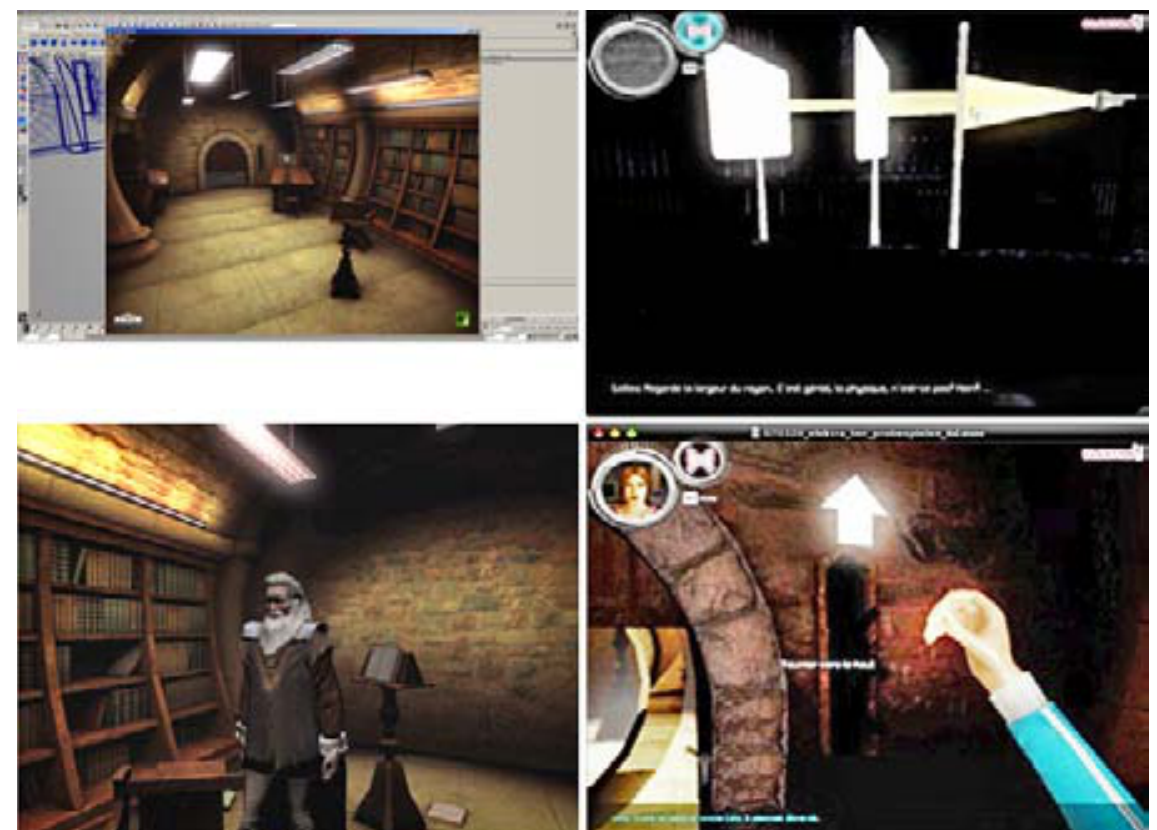
Figure 3. Design of Elektra with intrinsic support in the form of a pedagogical agent. Measurement Instruments Background